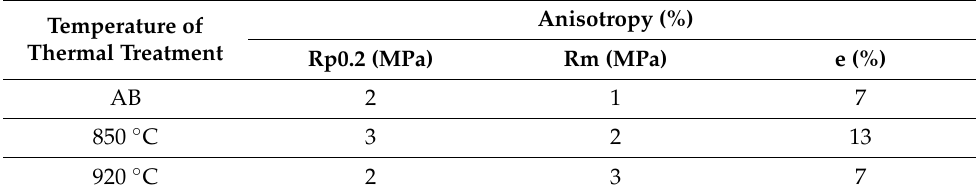
Table 7. Anisotropy of tensile properties calculated for single weld bead strategy after each ther- mal